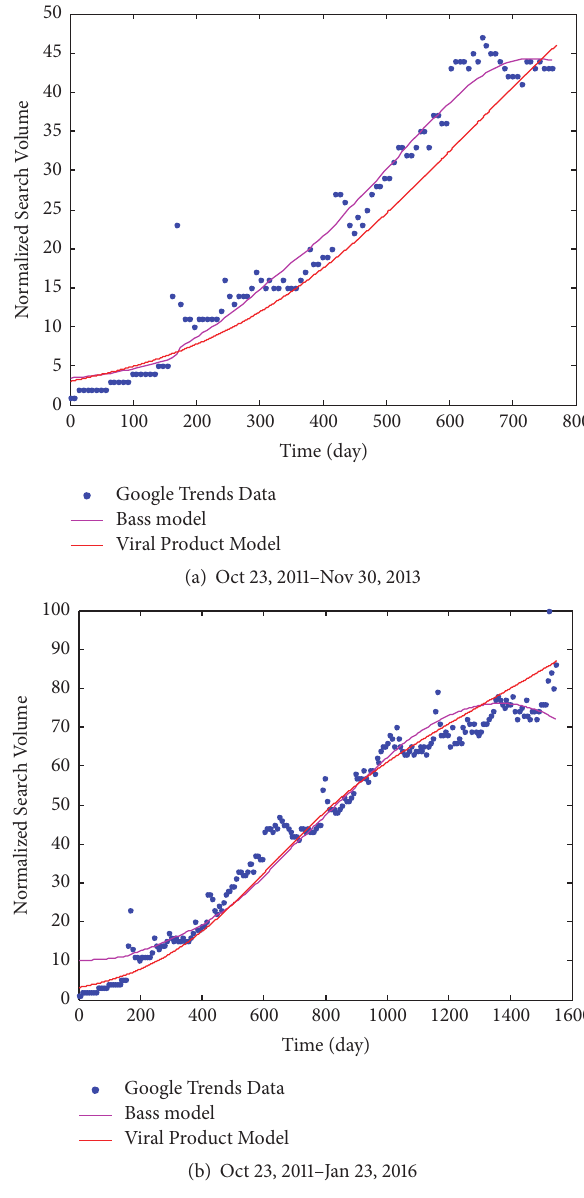
Figure 5: Actual data and curves predicted by two models for